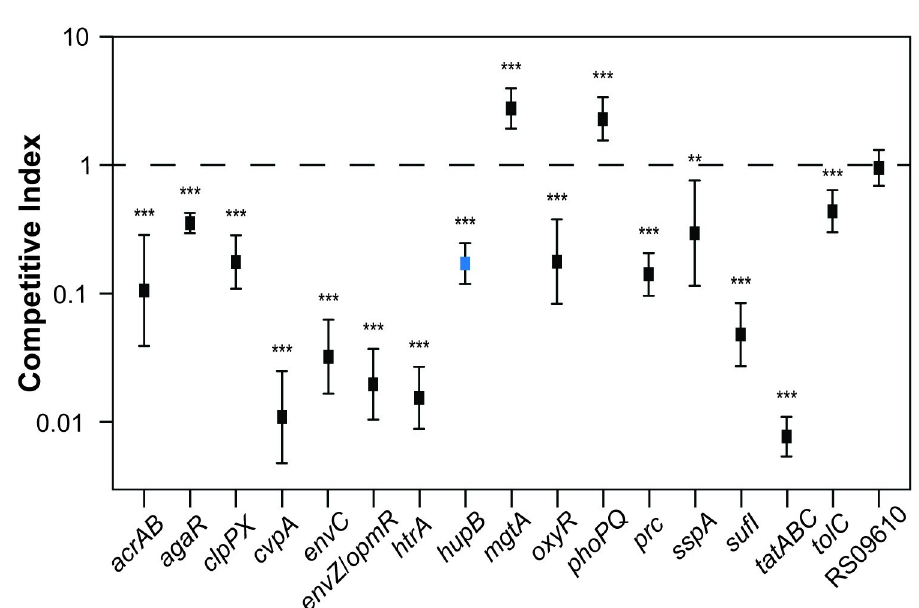
Fig 5. Validation of colonization defects in selected mutants. Competitive indices of indicated mutants vs wild type EHEC. Bar-coded mutants were co-inoculated with bar-coded wild-type EHEC into infant rabbits and recovered two days later from the colons of infected rabbits. Relative abundance of each mutant was determined by sequencing the barcodes. ( �� ) p-value < 0.01 and ( ��� ) p-value < 0.001. Δ hupB , which had a glPC1 score in the bottom 10%, but was not classified as CD by Con-ARTIST, is highlighted in